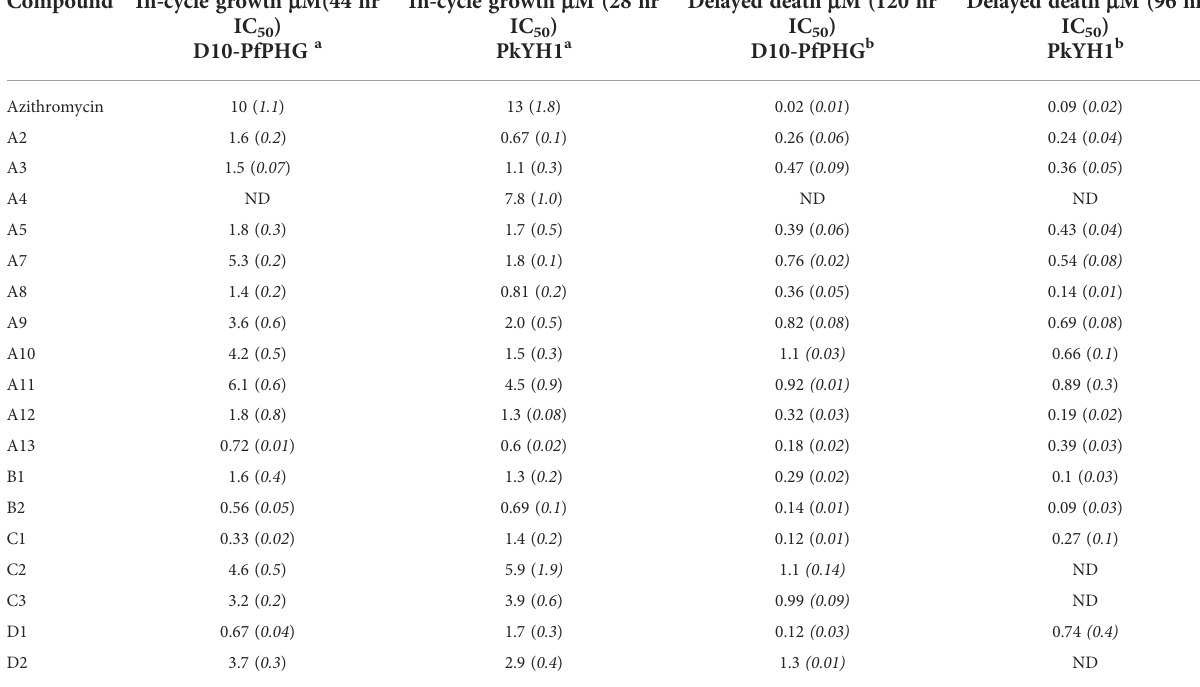
TABLE 1 In vitro ef fi cacy of azithromycin analogues against Plasmodium parasites. Compound In-cycle growth m M(44